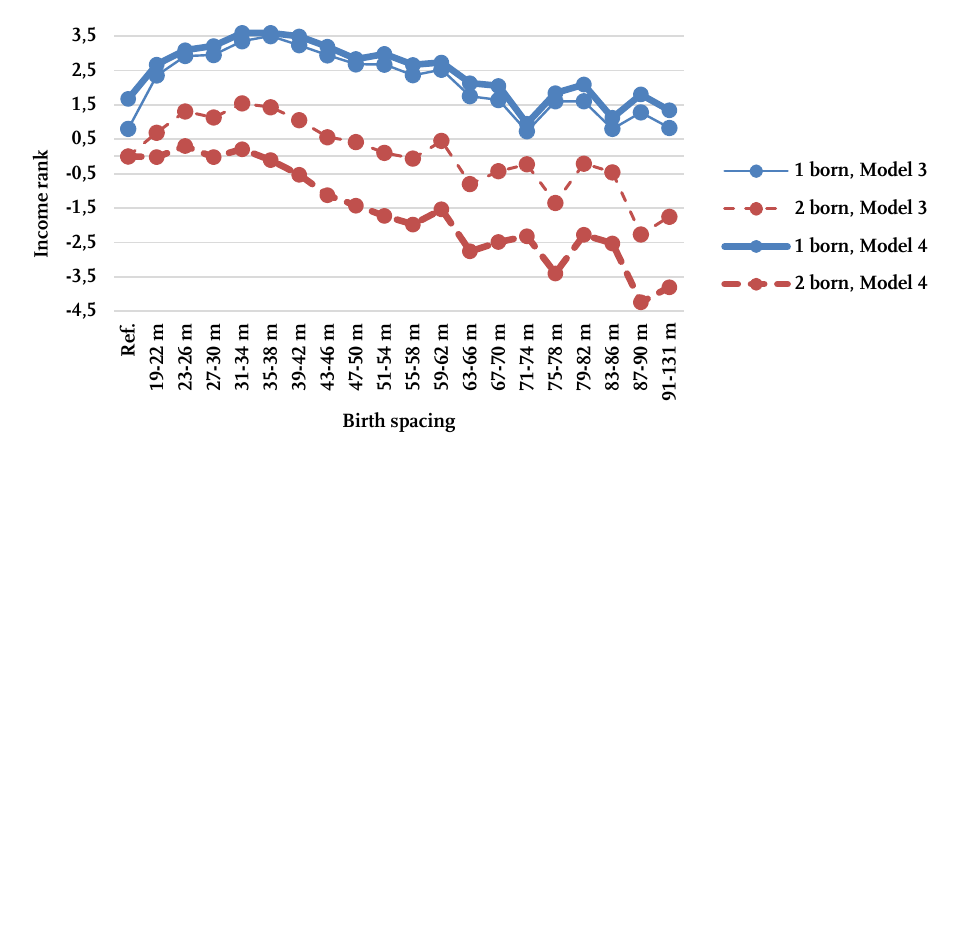
Panel B: Estimates from models 3 and 4, controlling for parent’s age at birth